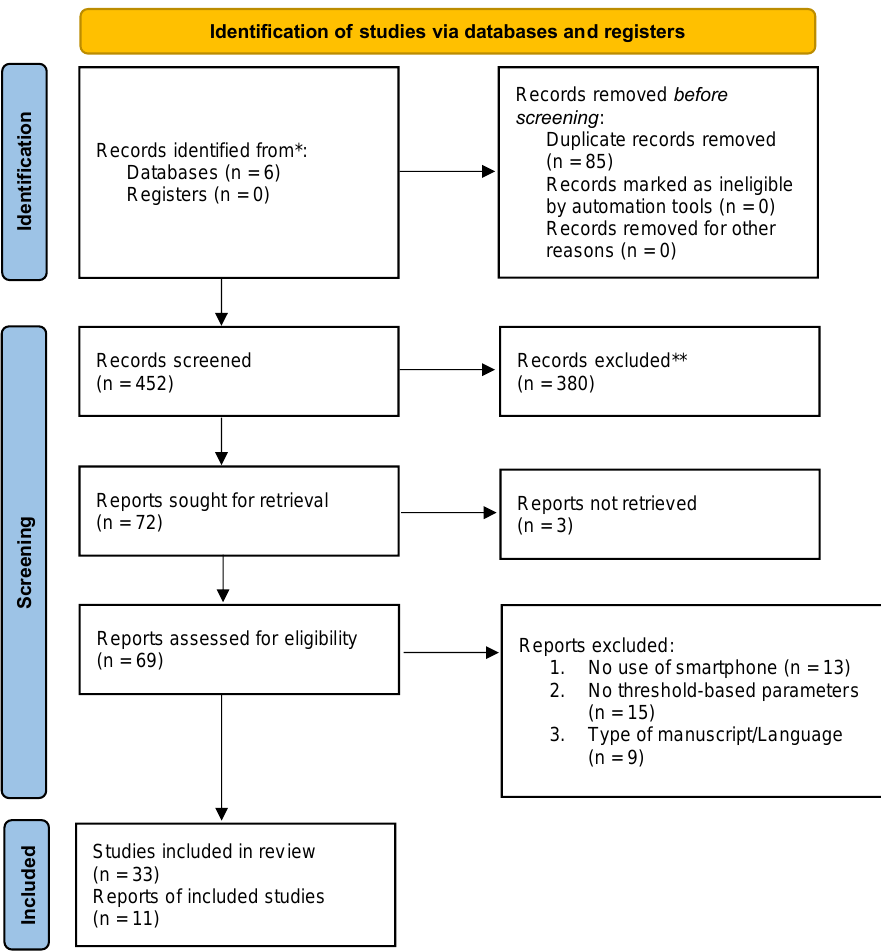
Figure 1. Study selection flow chart. Flow chart describing the study selection process according to PRISMA guidelines. (From: Page MJ, McKenzie JE, Bossuyt PM, Boutron I, Hoffmann TC,